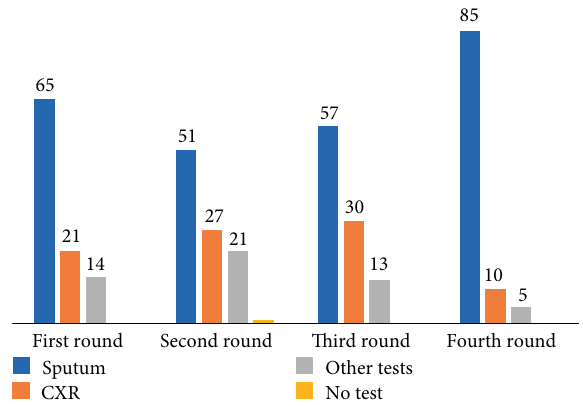
Figure 2: Health seeking behaviour for current medical condition of the study participants ( 𝑛 = 260 ). Types of diagnostic services received, % ( 𝑛 = 123 ).